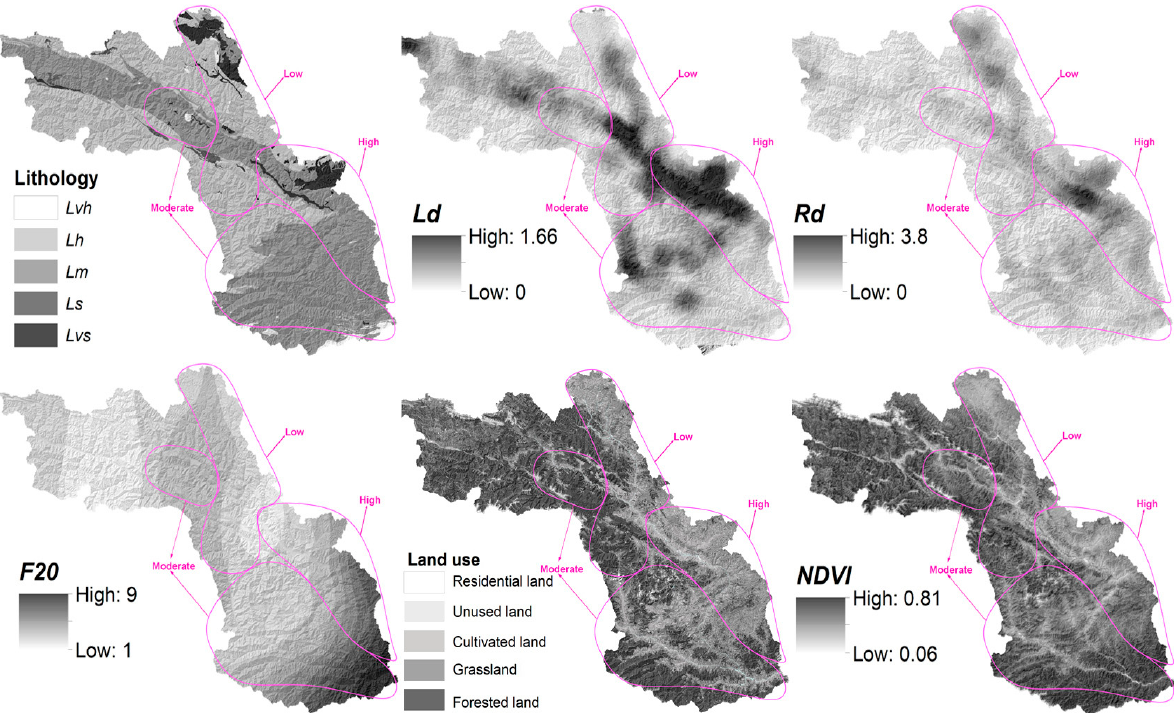
Figure 8. Distribution of important factors.